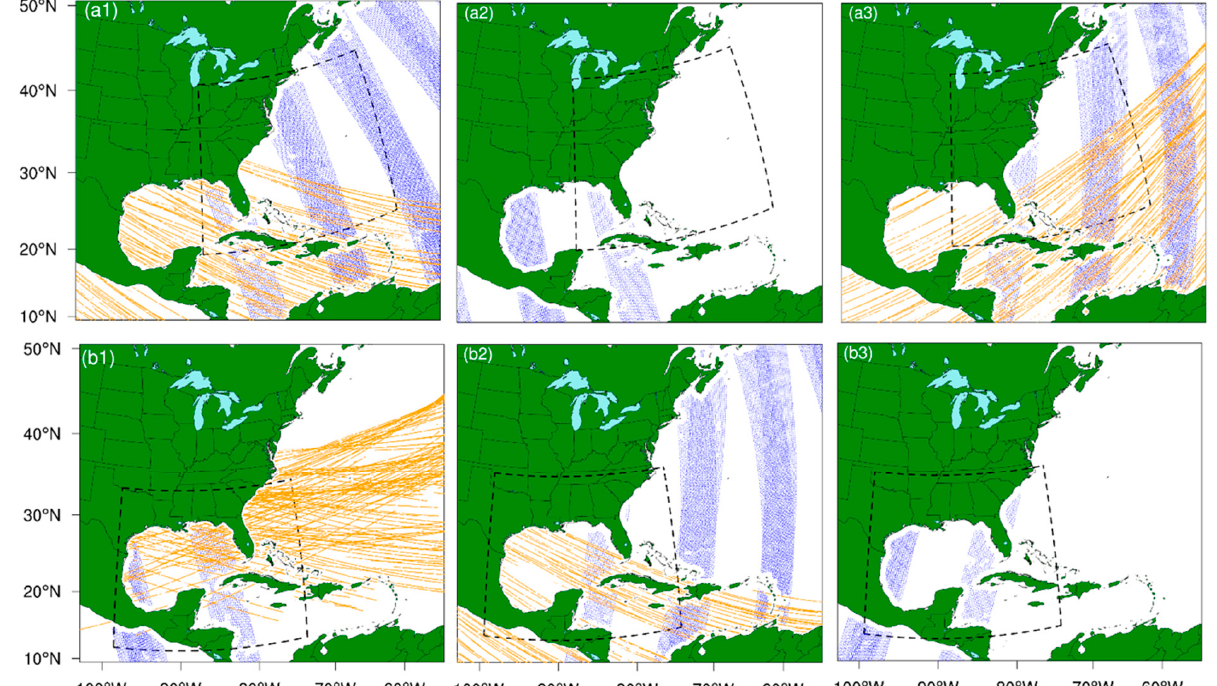
Figure 1. Available ASCAT and CYGNSS v2.1 data distribution for Florence and Michael at different assimilation times: ( a1 – a3 ) are, respectively, at 0000, 0600, and 1200 UTC on 13 September 2018; ( b1 – b3 ) are, respectively, at 0600, 1200, and 1800 UTC on 09 October 2018. Blue dots represent locations for ASCAT data and orange dots represent locations for CYGNSS data. The black dashed frames are the HWRF ghost domain for d02.